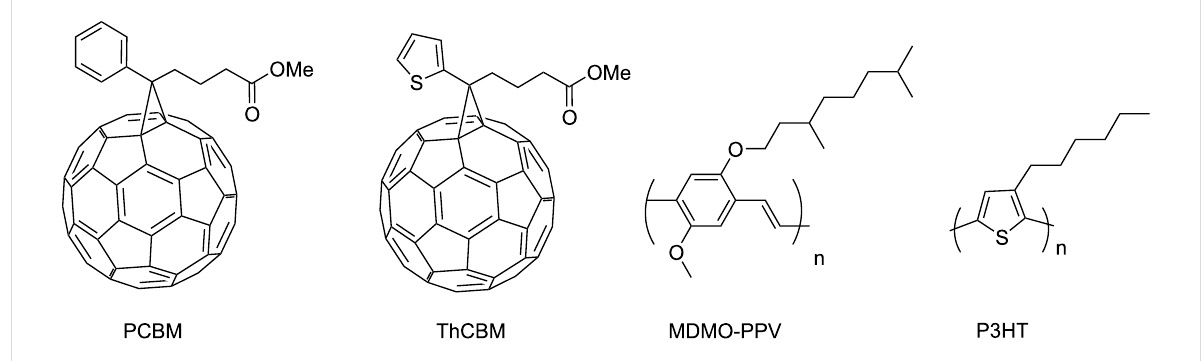
Figure 1: Molecular structures of PCBM, ThCBM, MDMO-PPV, and P3HT.